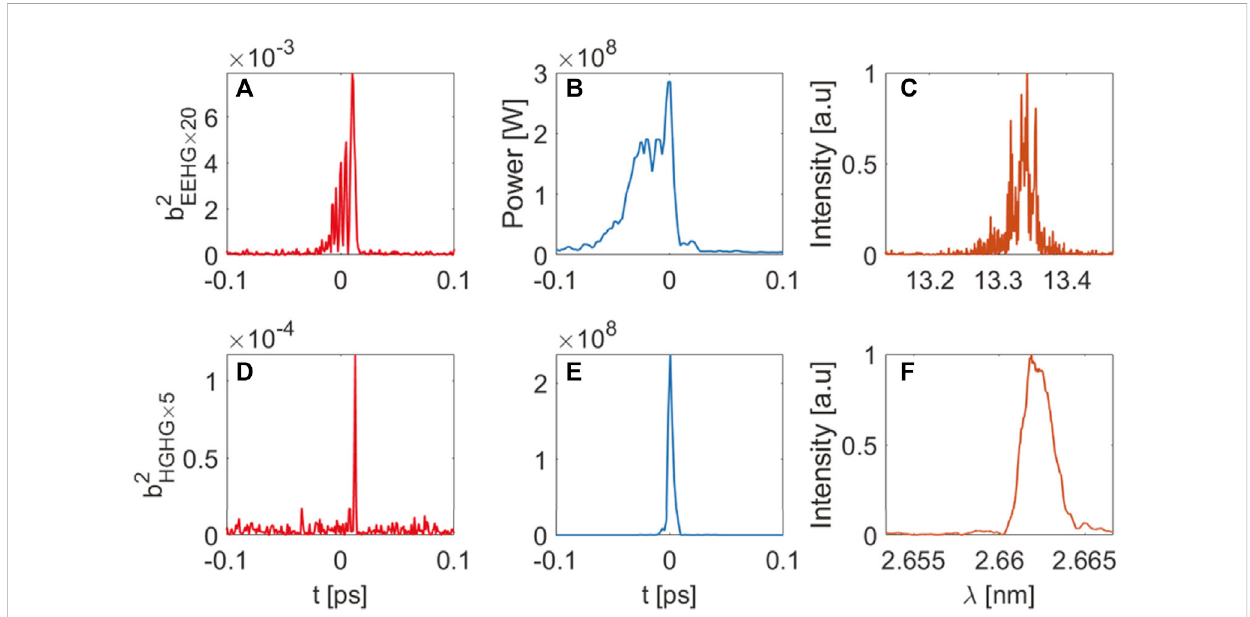
FIGURE 6 (A) Squared bunching factor of the simulation results at the entrance of RAD1 with a harmonic number of 20. (B) Power of the EEHG-FEL radiation. (C) Spectrum of the EEHG-FEL radiation. (D) Squared bunching factor of the simulation results at the entrance of RAD2 with a harmonic number of 5. (E) Power of the HGHG-FEL radiation. (F) Spectrum of the HGHG-FEL